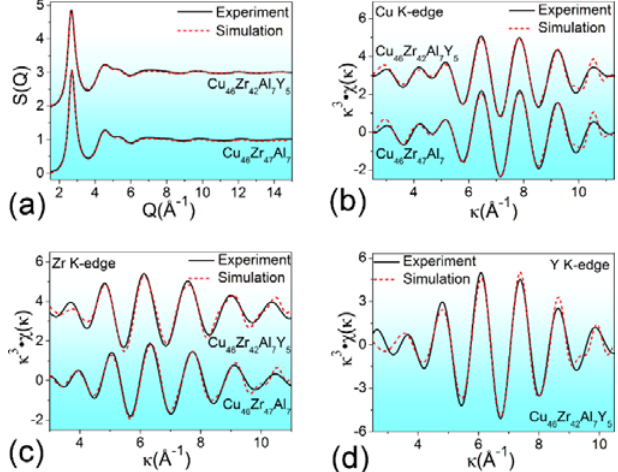
Figure 2. XRD and extended X ‐ ray absorption fine structure (EXAFS) experimental data as well as their corresponding simulated curves, including ( a ) S ( Q ); ( b ) Cu K ‐ edge, ( c ) Zr K ‐ edge, and ( d ) Y K ‐ edge EXAFS data. Experimental and simulated data are plotted with the solid and the dashed lines, respectively. All the experimental and the simulated signals were weighted by κ 3 . To highlight the S ( Q ) difference between the experimental and the simulated data for both samples, the Q region here was shortened to about 15 Å − 1 .